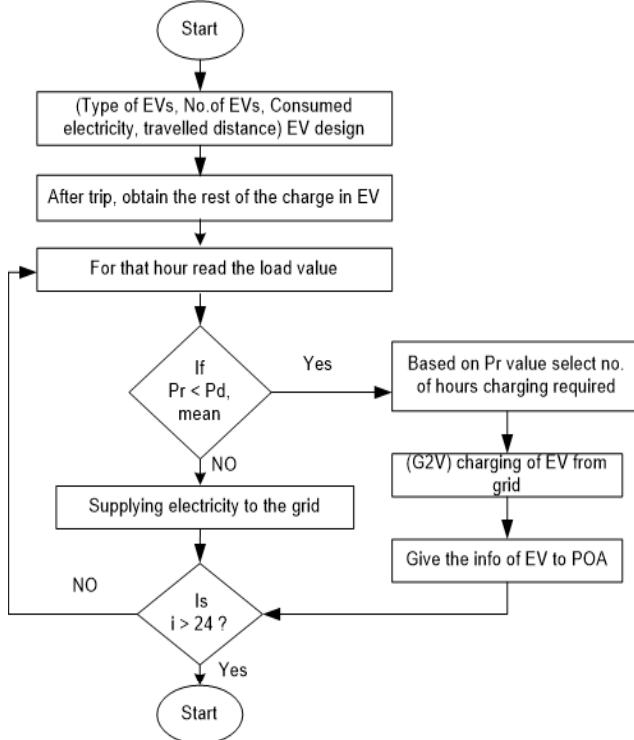
Figure 5. Procedure for placement of renewable DGs and EVs with VSI.